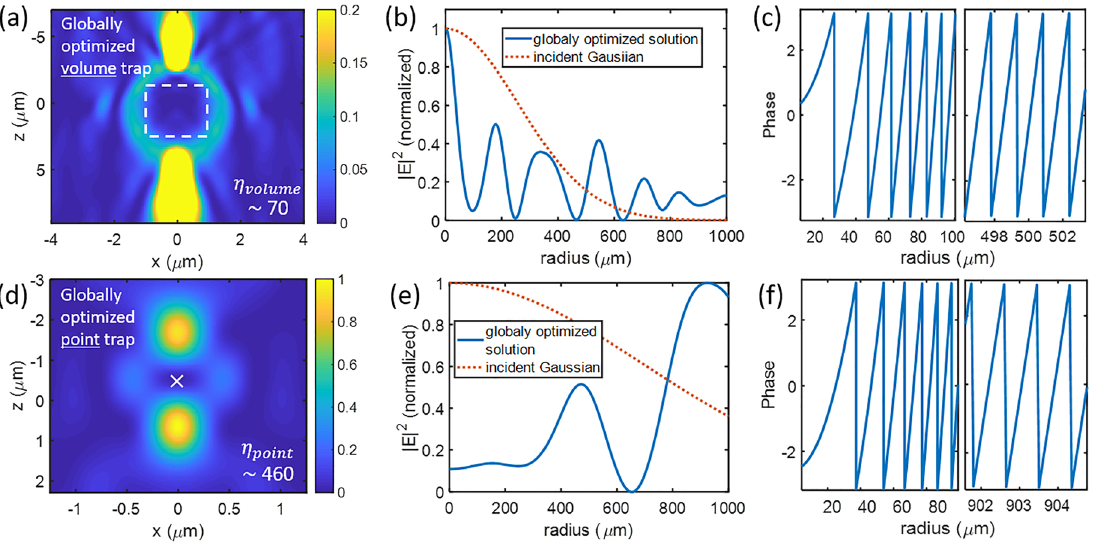
Figure 5: The best (a) volume and (d) point bottle-beam traps found by “ global ” gradient-ascent optimization [NA = 0.7 in (d)]. The corre- sponding intensity and the phase pro fi les of (a) and (d) at the metasurface plane are shown in (b), (c) and (e),